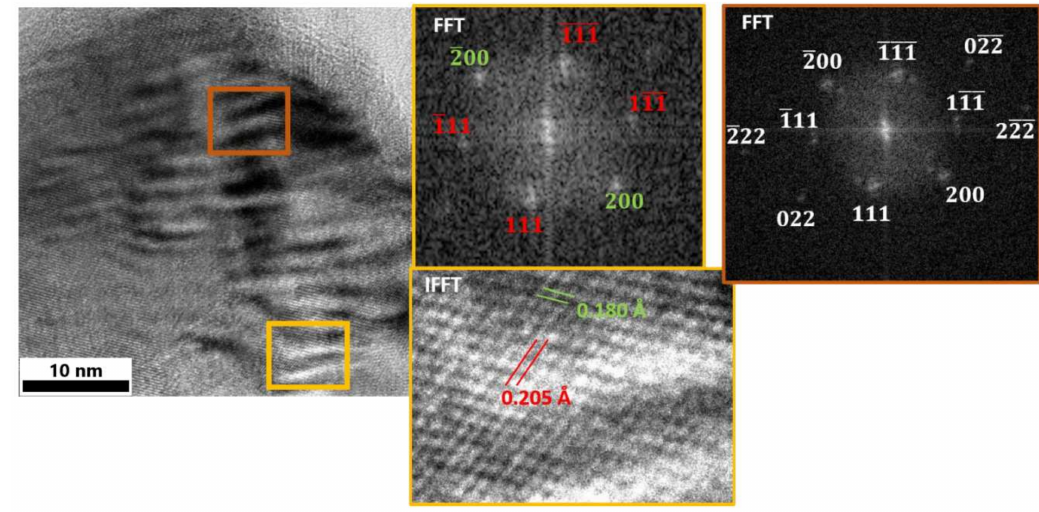
Figure 7. TEM image of a precipitate in the sample 1.5Cu QT 500 ◦ C / 60 min. It is probably two coalesced particles or two overlapping ones. Their structure corresponds to fcc